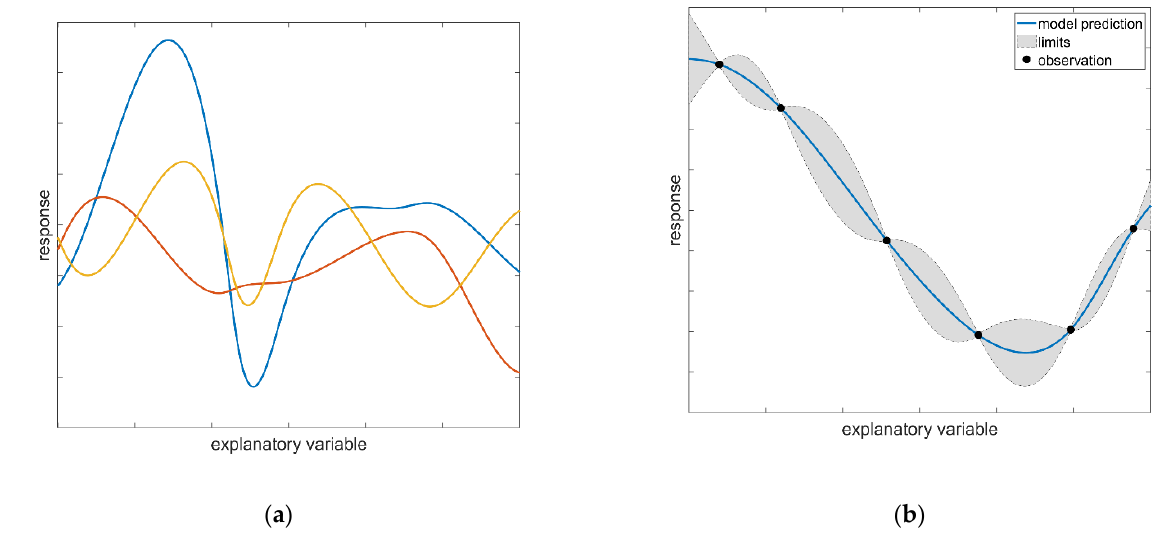
Figure 2. ( a ) three samples of the prior distribution specified by the mean and covariance function; ( b ) posterior distribution after observation of six data points.